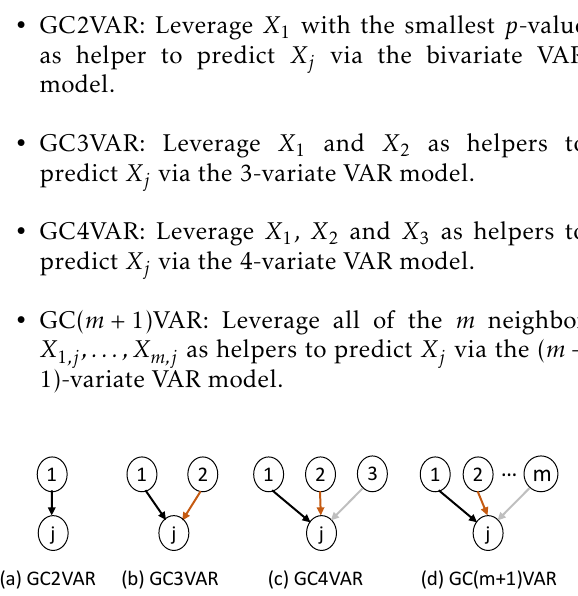
Figure 2. Illustration of GC ( z + 1) VAR, where prefix “GC” indicates leveraging G-causality and arrows are colored to indicate their respective p -values with p